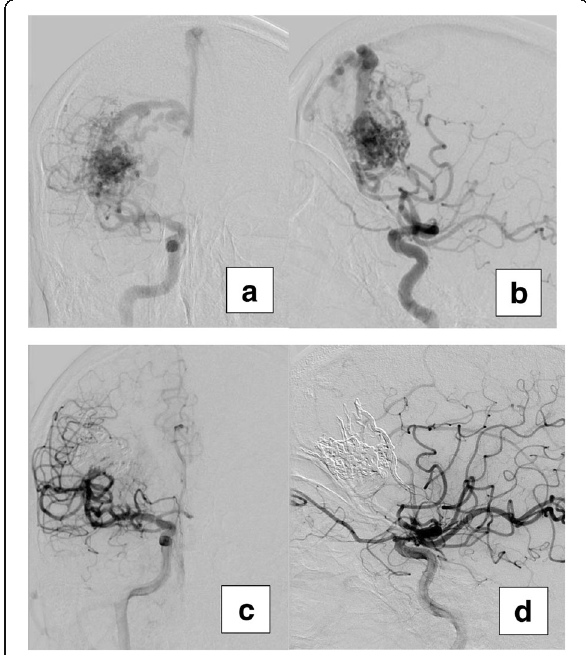
Fig. 1 An elderly patient with a ruptured small right frontal brain AVM. a Frontal view of a right internal carotid angiogram shows multiple feeders from the middle cerebral artery and superficial venous drainage. b Lateral view. c , d Final result